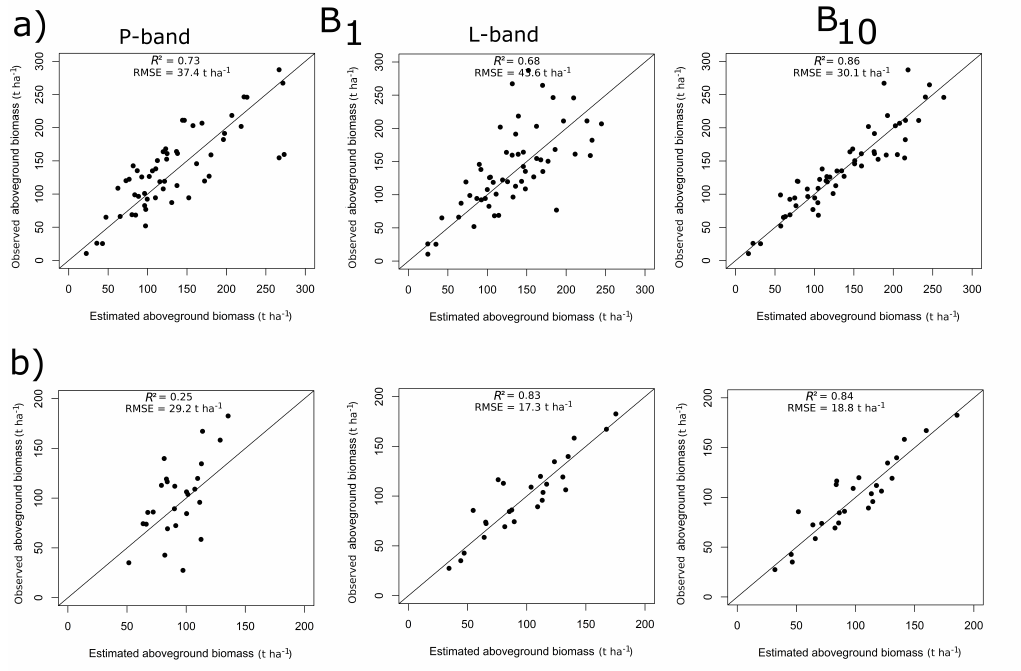
Figure 7. Estimated aboveground biomass using biomass models B 1 with P-band ( left ), B 1 with L-band ( center ) and B 10 ( right ) compared to actual aboveground biomass in Remningstorp ( a ) and Krycklan ( b ; line corresponds to a 1:1